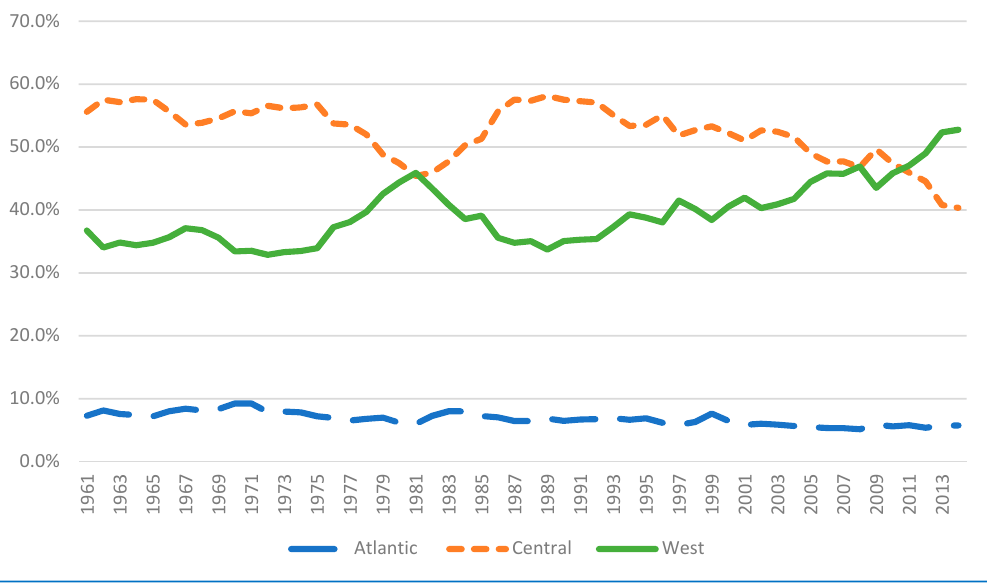
Figure 2. Share of national capital investment by region. Source: Statistics Canada. Table 031-0005—Flows and stocks of fixed non-residential capital, by industry and asset.